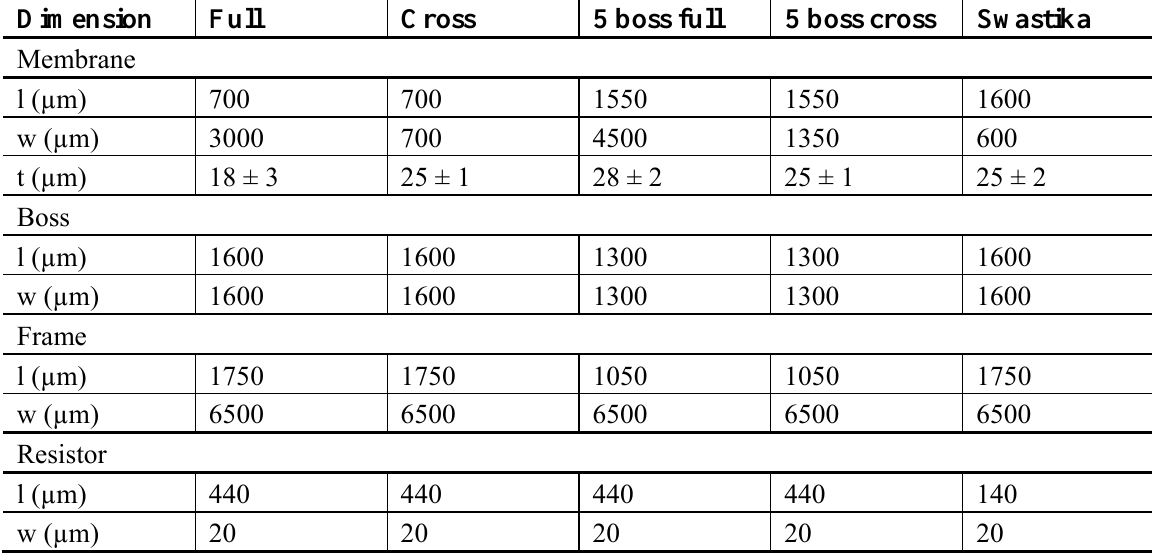
Table 1 . Summary of dimensions of five different membrane